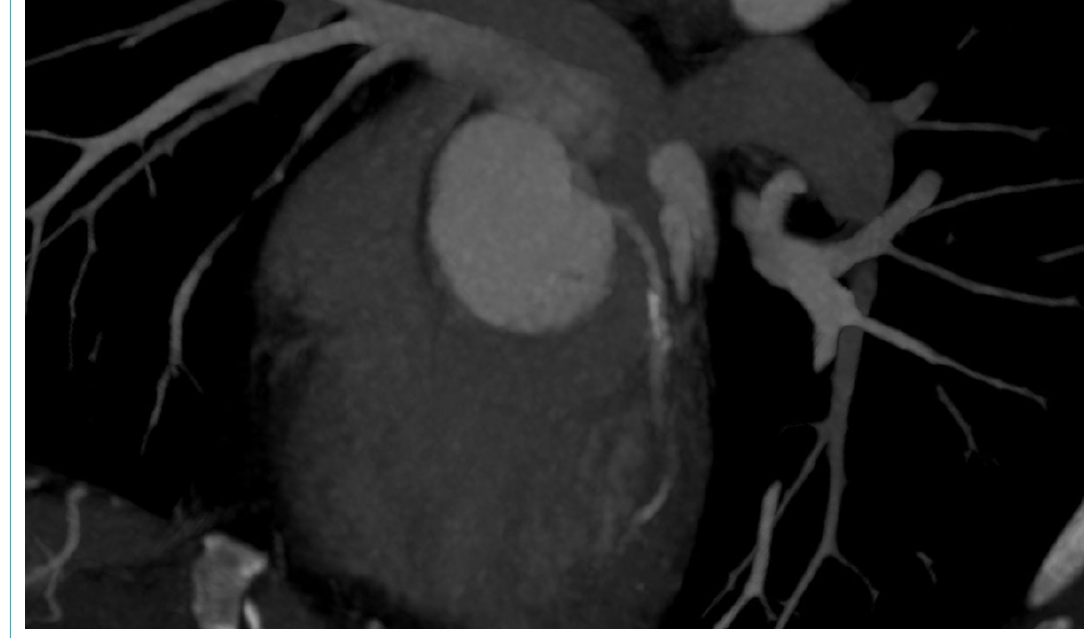
Figure 1: Axial CT scan of the left coronary artery in a 43-year old ED patient showing coronary artery calcification which led to a coronary an-